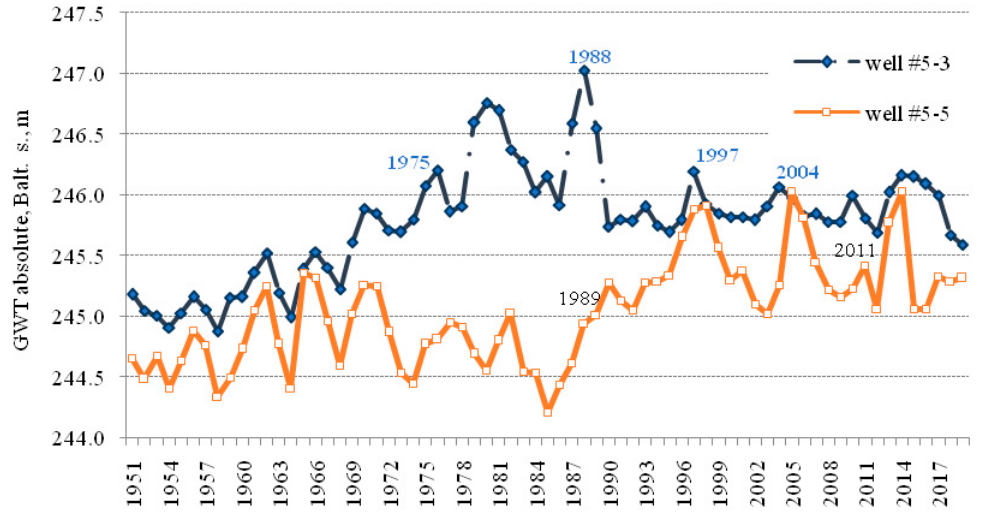
Figure 5. Chronological graphs of GWT in the wells: #5-3 (GWT = 1.0–2.5 m) and#5-5 (GWT = 2.5–4.5 m), aquifer in alluvial Upper Neo-Pleistocene and Holocene sediments of the first flood-plain terrace, Khmilnyk, Vinnytsia region, Ukraine.